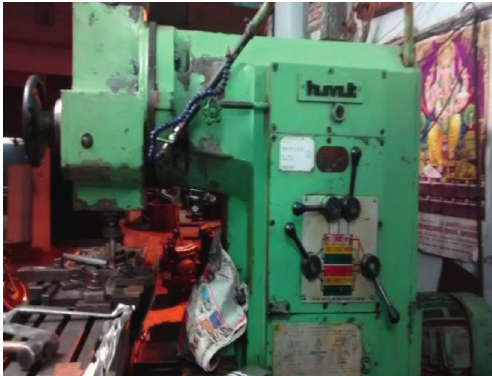
Figure 4: Machine used for